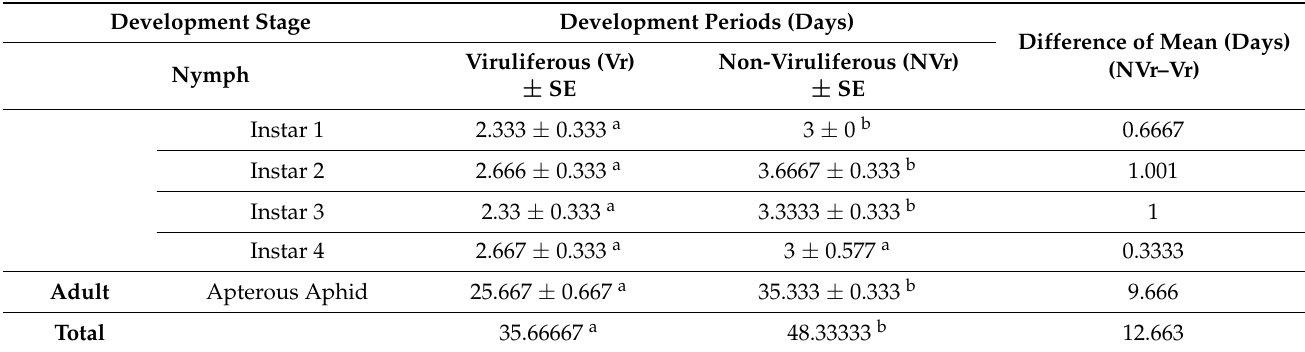
Table 2. Comparison of the developmental period of each stage of NVr and Vr P. nigronervosa . Development